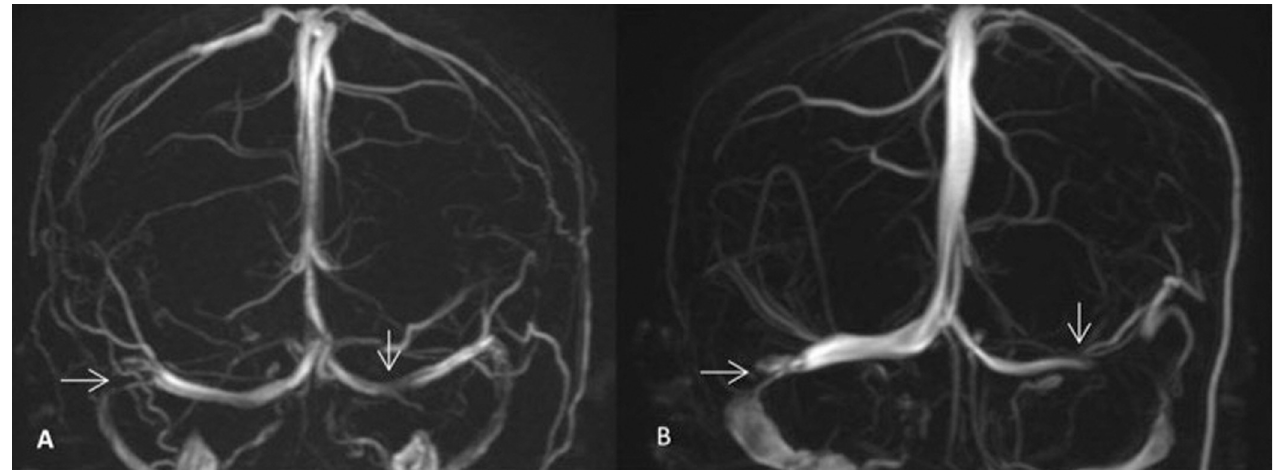
Fig 3. TSS on MRV. A and B showed narrowing in bilateral transverse sinus.